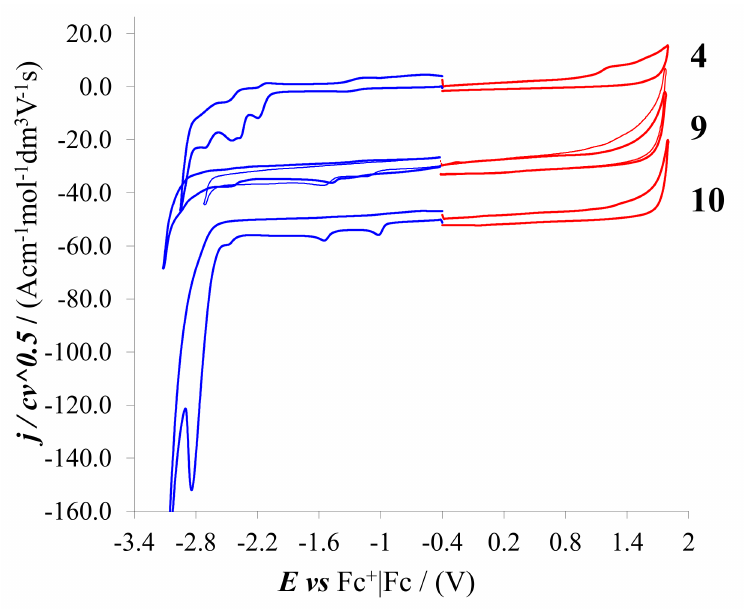
Figure 9. CV patterns for compound 4 and for the bis-triflimidates 9 and 10 , 0.00075 M solutions in